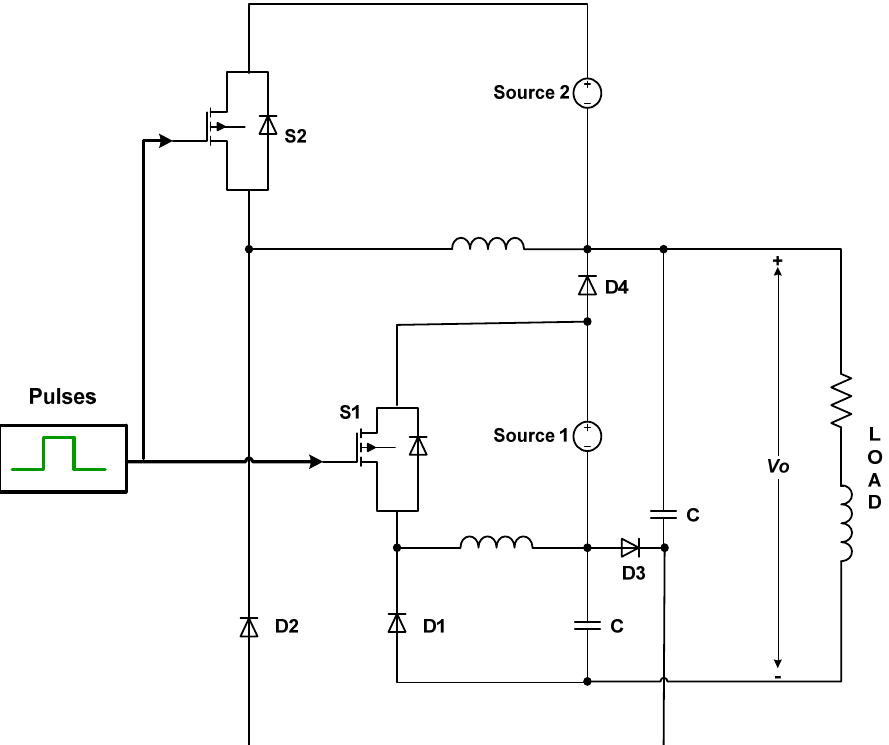
Figure 1. Suggested buck-boost DC–DC converter.